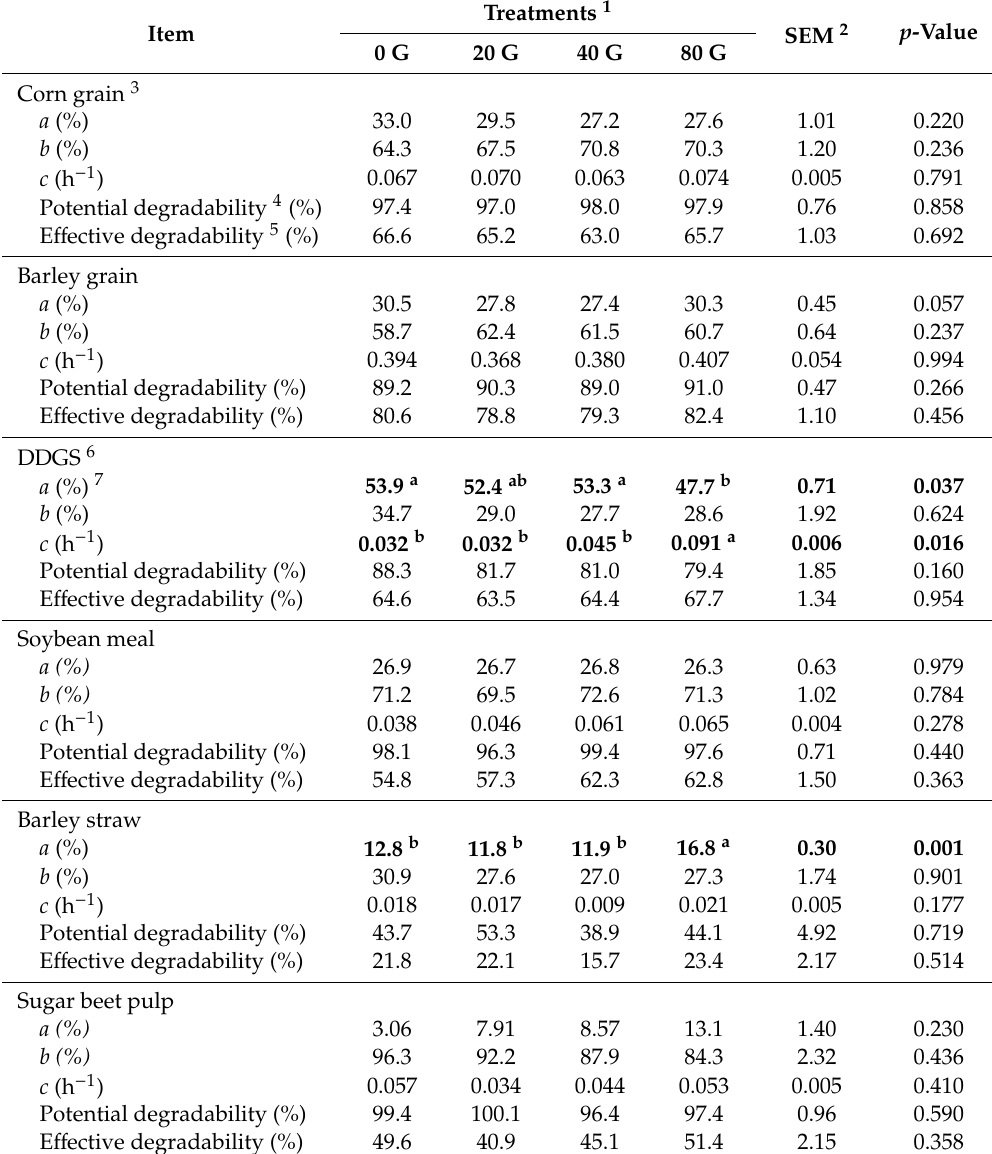
Table 5. The parameters of degradability and the potential and e ff ective degradability of dry matter of di ff erent substrates in young bulls that were fed a high level of